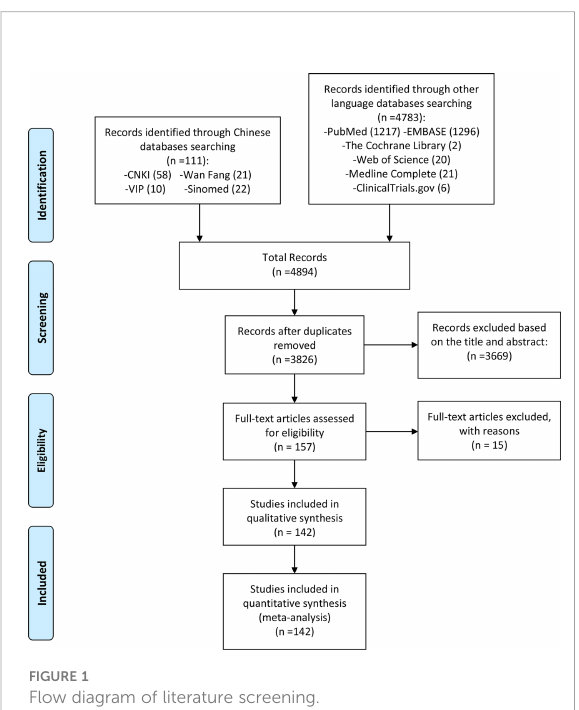
FIGURE 1 Flow diagram of literature